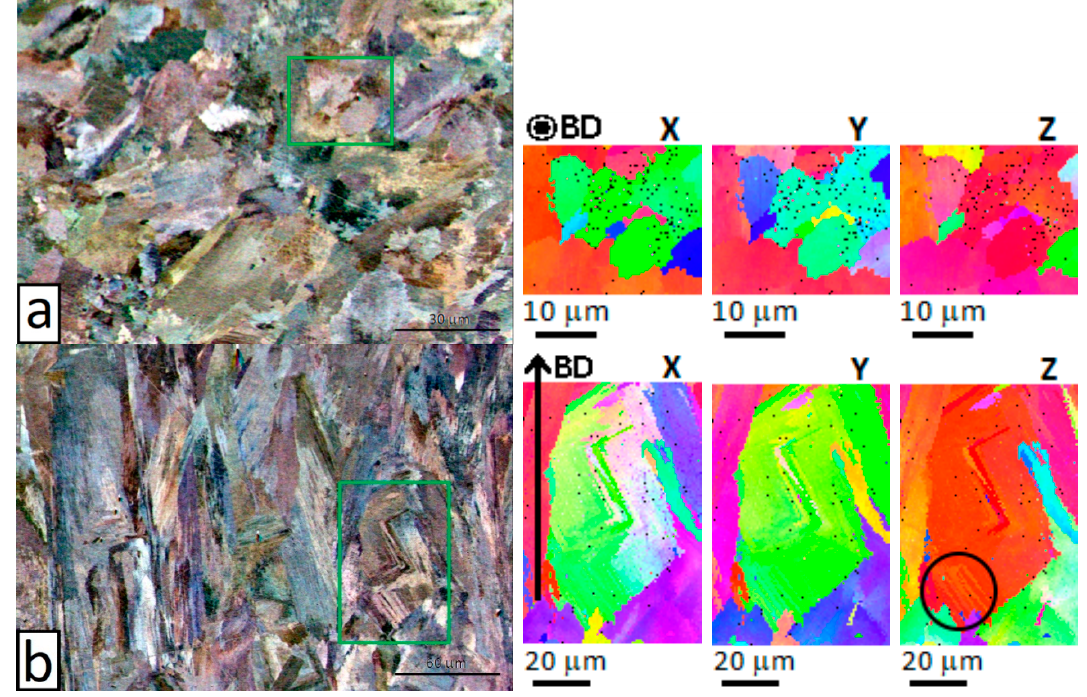
Figure 9. Forescattered/backscattered electron images on the horizontal plane ( a ) and vertical plane ( b ) with relative inverse pole figure (IPF) maps at higher resolution of the areas marked by the green boxes.